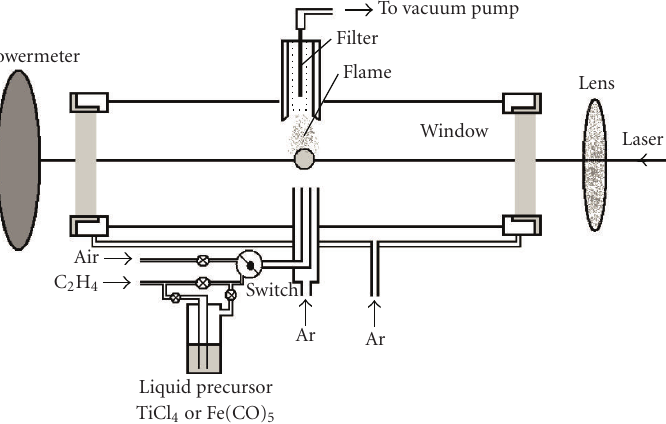
Figure 1: Schematic view of the laser pyrolysis setup for the production of iron oxide and titania nanoparticles, respectively.